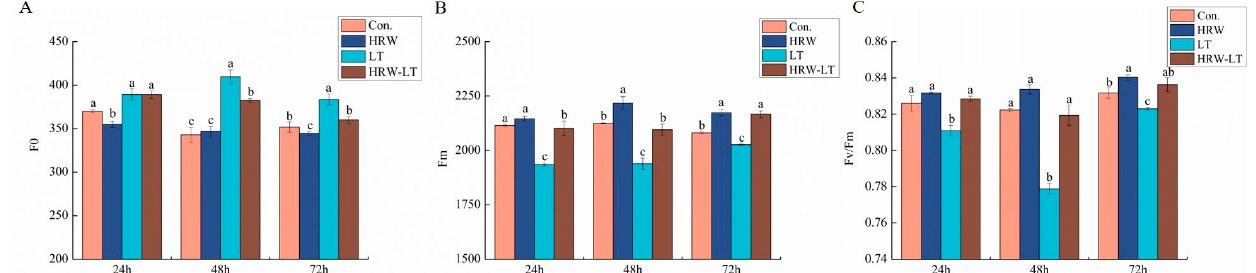
Figure 6. Effect of HRW on the fluorescence parameters of cucumber seedlings under chilling stress. ( A ) F0; ( B ) Fm; ( C ) Fv/Fm. Data are the mean ± standard deviation of three biological replicates. The different letters indicate a significant difference ( p < 0.05).